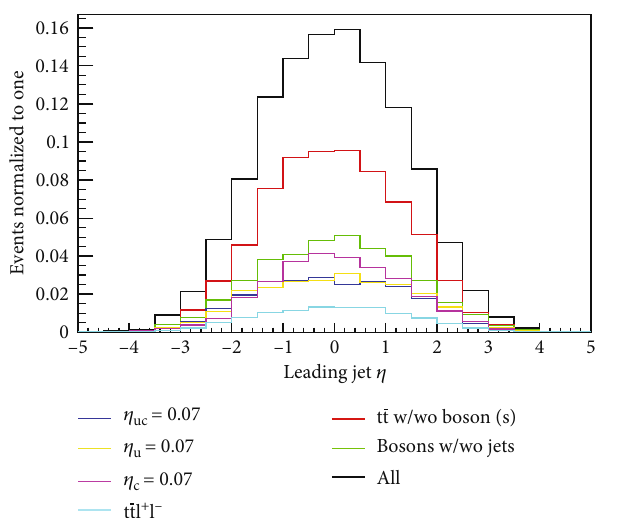
Figure 15: Leading jet η distribution at detector is central.